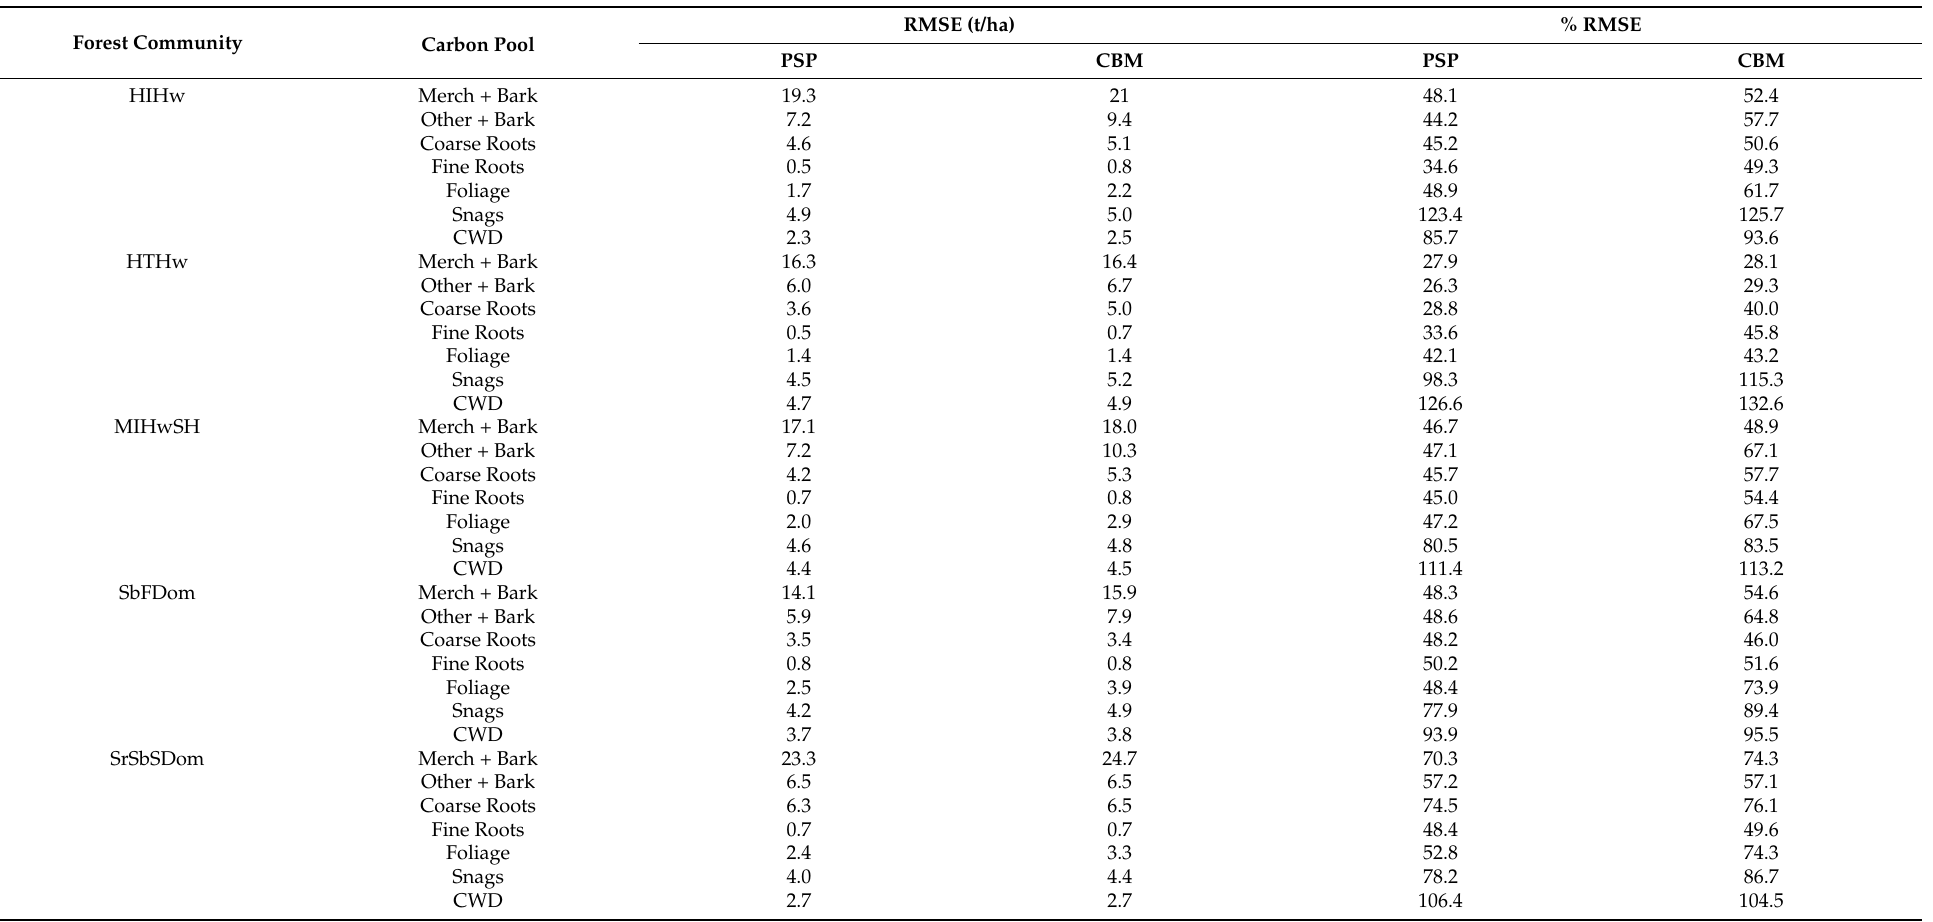
Table A2. Root Mean Square Error (RMSE) and Percent RMSE of both estimation methods against an independent PSP dataset ( n = 100 per community) by forest community and carbon